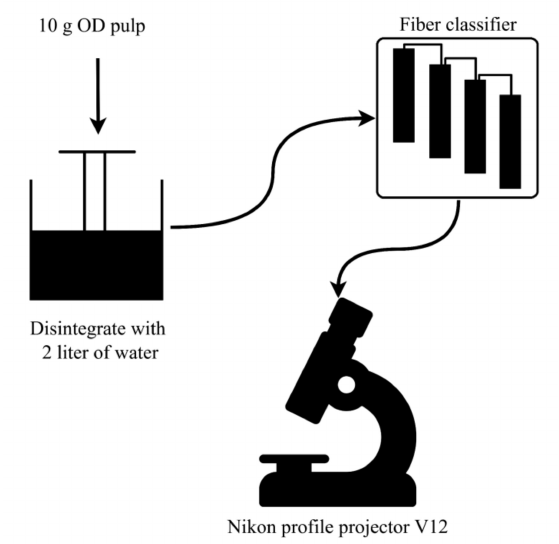
Figure 4. Classification of Kenaf